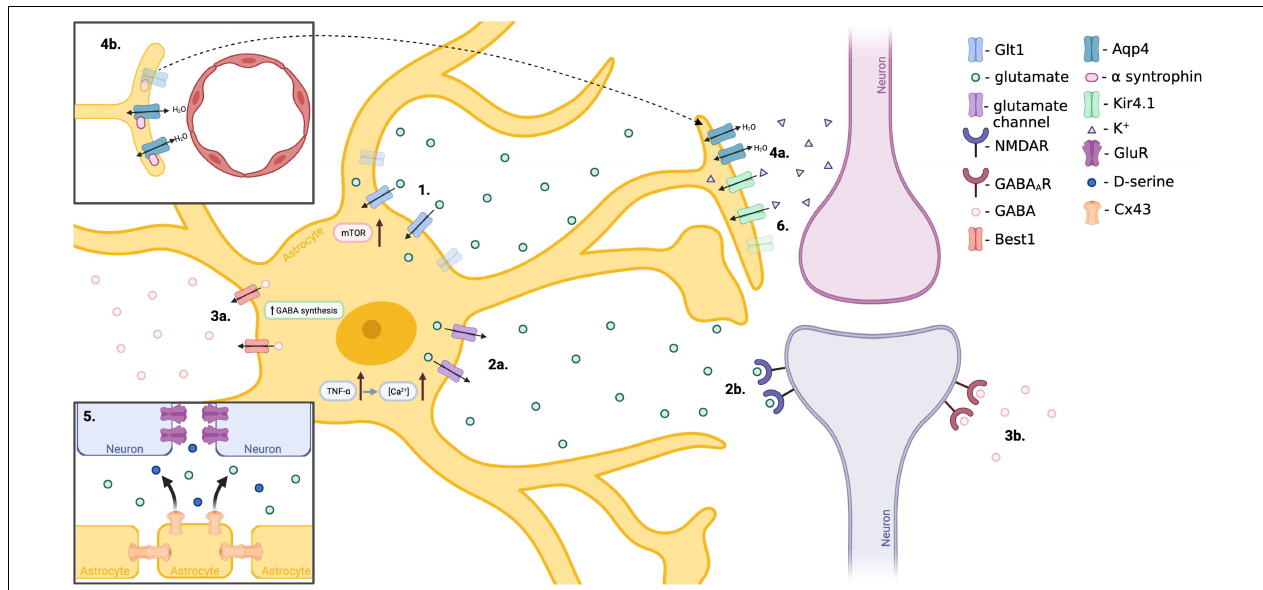
FIGURE 4 | Proposed mechanisms of astrocyte involvement in TLE. (1.) Hyperactivation of mTOR within reactive astrocytes decreases Glt1 stability, resulting in reduced extracellular glutamate clearance and enhanced neuronal excitability. (2.) Increased expression of astrocytic TNF α results in excess release of glutamate from astrocytes in a Ca 2 + dependent manner, affecting neuronal excitability. (3.) Reactive astrocytes over-produce and release inhibitory GABA through the Best1 channel as a compensatory mechanism to offset the excitatory shift of neurons in epilepsy. (4.) Reduced expression of alpha-syntrophin, responsible for anchoring adluminal Aqp4, results in mislocalization of adluminal Aqp4 to abluminal astrocytic endfeet. This mislocalization results in disrupted water homeostasis and is associated with delayed K + clearance. (5.) Neuronal GluR expression is increased in TLE. Astrocytic Cx43 hemichannels release glutamate and D-serine resulting in pro-epileptic connexin activity. (6.) Loss of astrocytic Kir4.1 potassium channel results in disturbed K + buffering and more positive neuron resting potential, enhancing neuronal excitability. (Created with